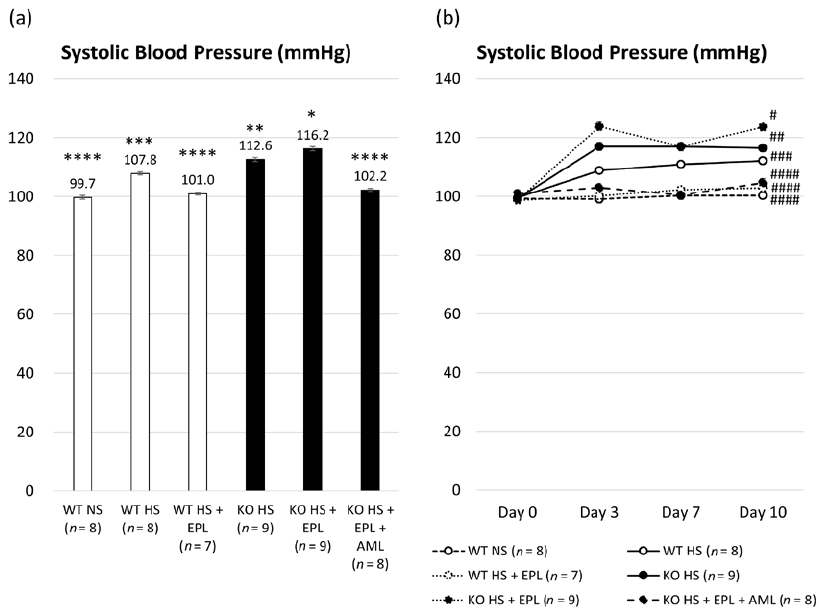
Figure 1. Systolic blood pressure (SBP) measured using the tail-cuff method. ( a ) Average SBP in each group for whole experimental periods analyzed by one-way ANOVA; ( b ) Average SBP on days 0, 3,